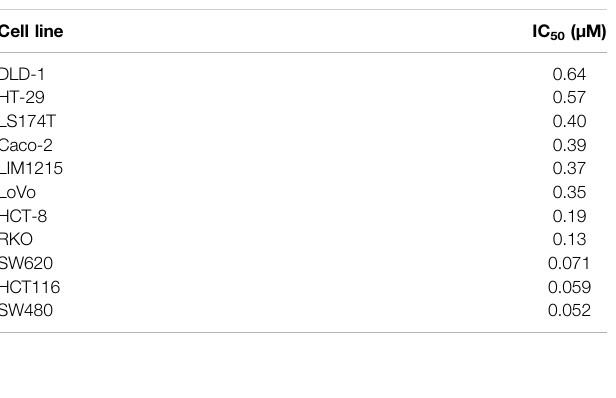
Frontiers in Pharmacology |